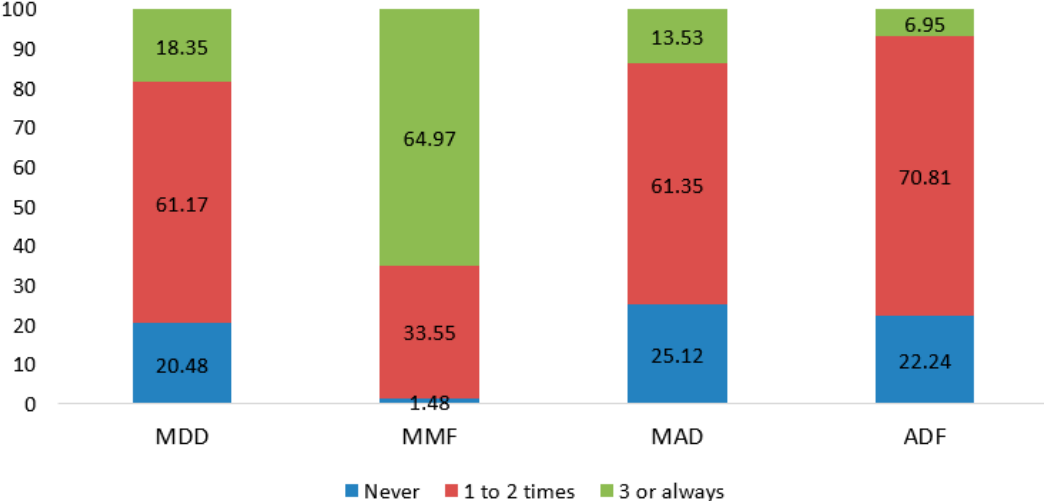
Figure 4. Percentage of adherence to age-appropriate feeding practices in children aged 0–23 months from the 1st to 4th follow-up. MDD = minimum dietary diversity; MMF = minimum meal frequency; MAD = minimum acceptable diet; and ADF = age-appropriate daily feeding.